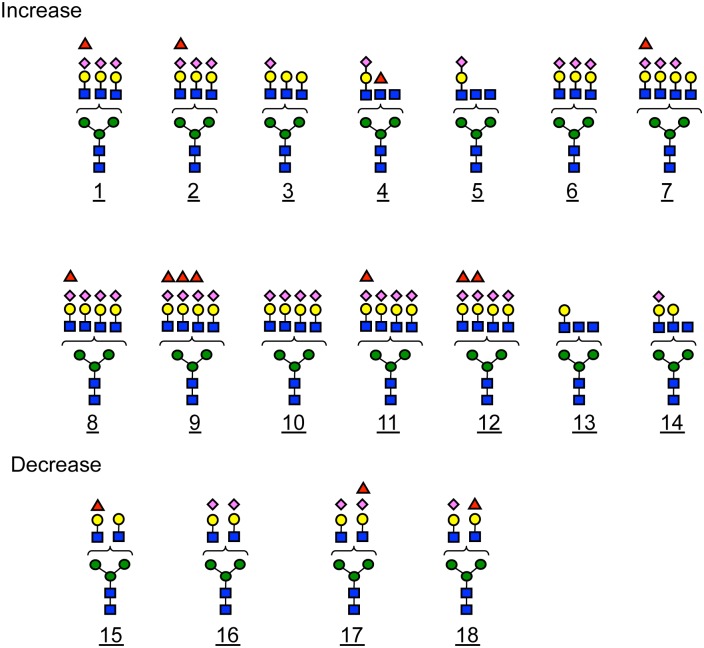
Deduced structures of characteristic N-glycans in SSCs.The number of the N-glycan corresponded to Table 1. No. 1~14 were increased and No. 15~18 were decreased in SSCs, respectively. blue square, N-acetylglucosamine; yellow circle, galactose; green circle, mannose; purple diamond, N-acetylneuraminic acid; red triangle, fucose.